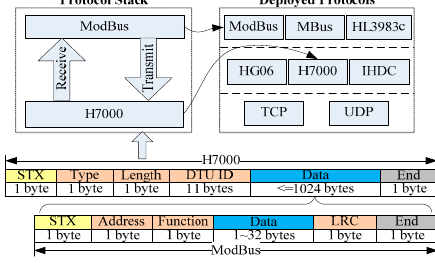
Figure 9. Example of protocol stack.